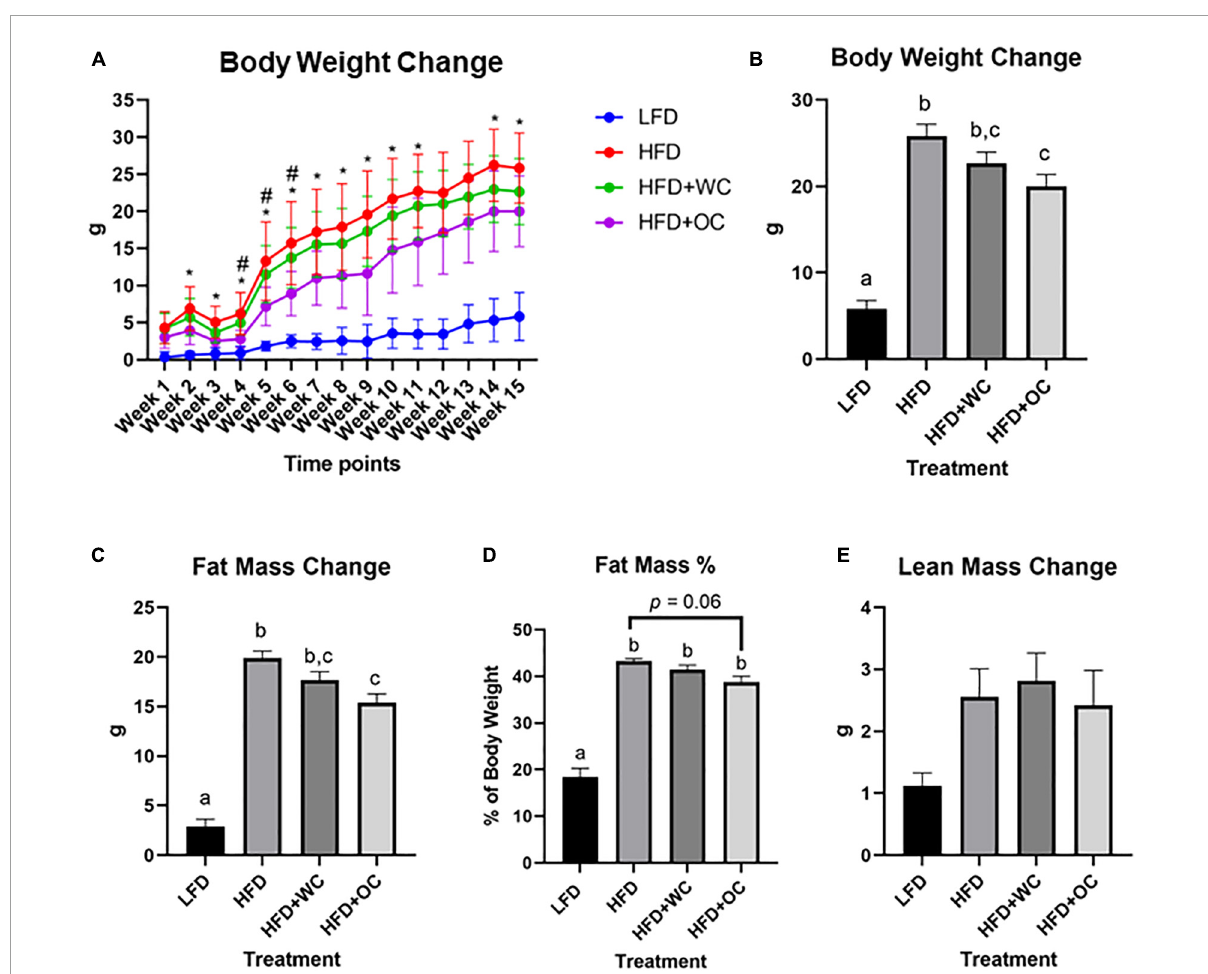
FIGURE1 Orange carrot-rich diet inhibited HFD-induced changes in body composition. LFD: n = 11; HFD, HFD + WC, HFD + OC: n = 12. (A) Weekly changes in body weight compared to baseline (week 0), *HFD vs. HFD + OC, p < 0.05; #HFD + WC vs. HFD + OC, p < 0.05. (B) Body weight change at endpoint (week 15) compared to baseline. (C) Change in fat mass determined by EchoMRI. (D) Fat mass percentage of Week 15 body weight. (E) Change in lean mass determined by EchoMRI. Values are means ± SEM. Body weight change was analyzed by two-way mixed ANOVA with post hoc Tukey HSD. Changes of body weight, fat mass and lean mass were analyzed by one-way ANOVA with post hoc Tukey HSD. Letter difference indicate statistical significance ( p < 0.05).